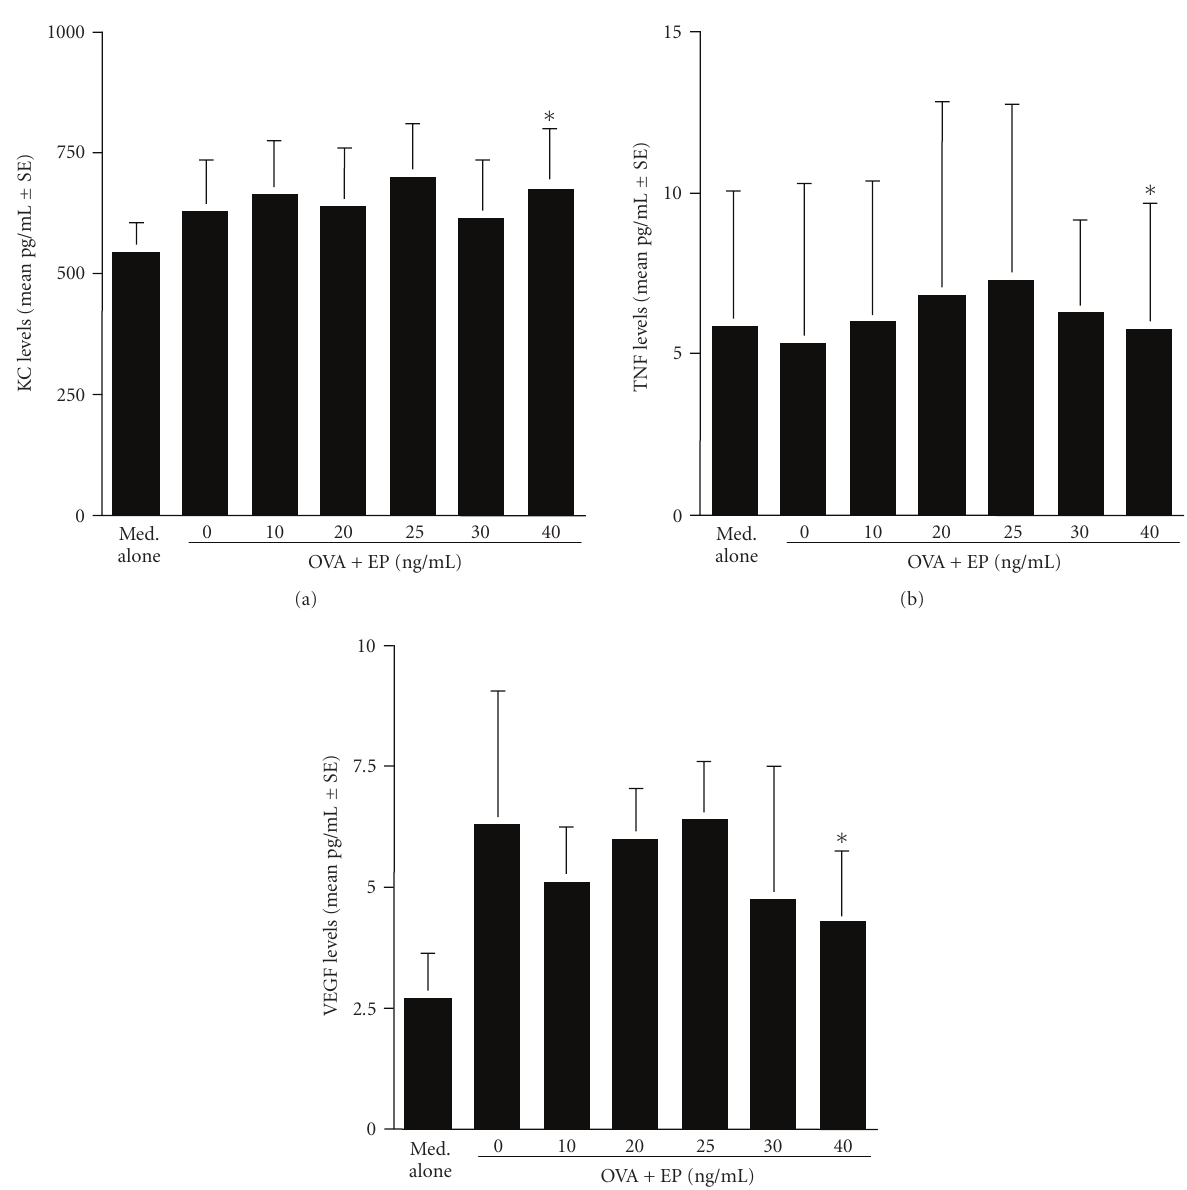
Figure 2: Influence of epinastine hydrochloride (EP) on angiogenic factor release from mast cells in IgE-dependent mechanism. Murine peritoneal mast cells (5 × 10 5 cells/mL) sensitized with IgE specific for ovalbumin (OVA) were stimulated with 10ng/mL OVA. After 4 hours, cells were collected, sonically disrupted, and the levels of angiogenic factors in cytosole were examined by ELISA. The data are expressed as the mean pg/mL ± SE of triplicate cultures. KC: keratinocyte-derived chemokine (a); TNF: TNF- α (b); VEGF: vascular endothelial growth factor (c); ∗ P < . 05 versus control (EP at 0